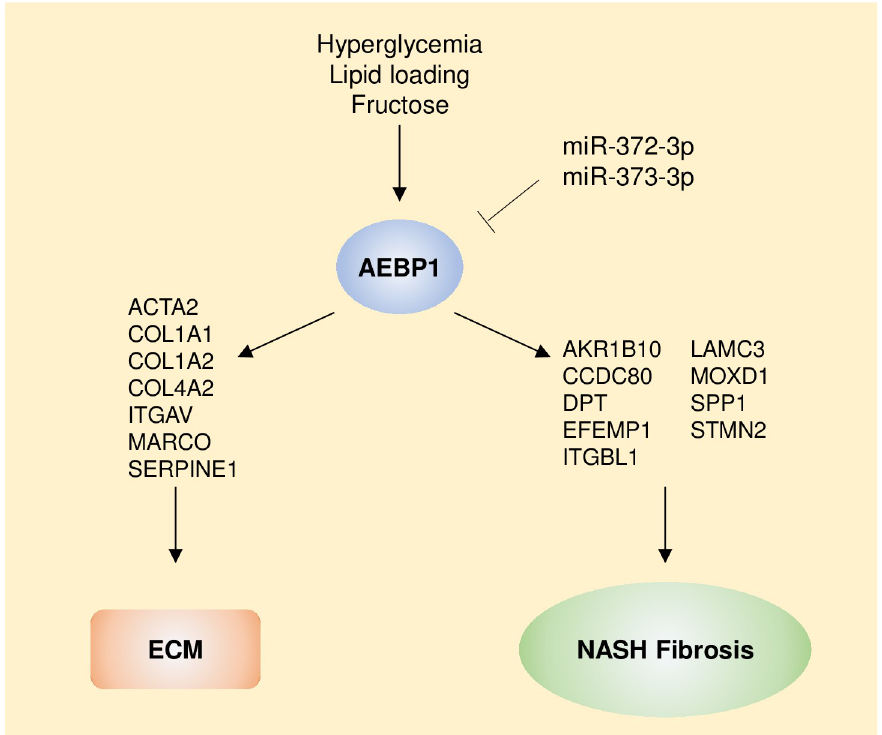
Fig 6. Potential mechanism by which AEBP1 affects the development of fibrosis in NASH. Hyperglycemia, lipid loading, and fructose treatment cause an increase in AEBP1 expression in liver cells. miR-372-3p and miR-373-3p, which are reduced in NAFLD patients with advanced fibrosis, functionally interact with AEBP1 to downregulate its expression. Increased expression of AEBP1 is associated with altered expression of key components of the ECM and algorithmically predicted target genes belong to a core set of fibrosis-specific genes previously identified by the authors.